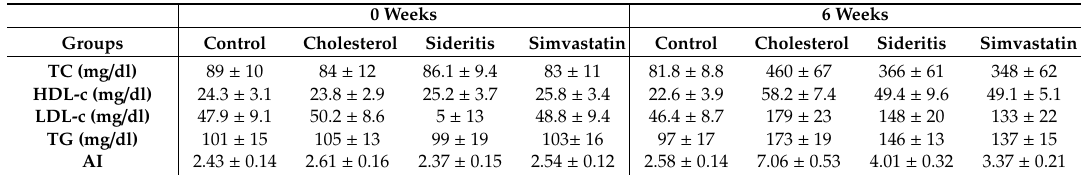
Table 2. Lipid profile and atherogenic index (mean ± SD) of the di ff erent groups (n = 6) at the beginning and at the end of the treatments (6 weeks). 0 Weeks 6 Weeks Cholesterol Sideritis Simvastatin